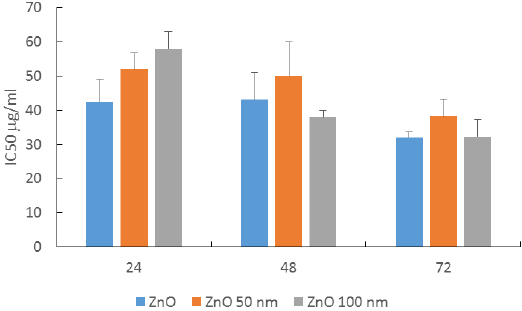
Figure 3. IC 50 values calculated from the curves of cell viability of HaCaT cells exposed to ZnO and ZnO 50 and 100 nm after 24, 48 and 72 h incubation. Mean values ± standard deviation of triplicates of at least three independent experiments.